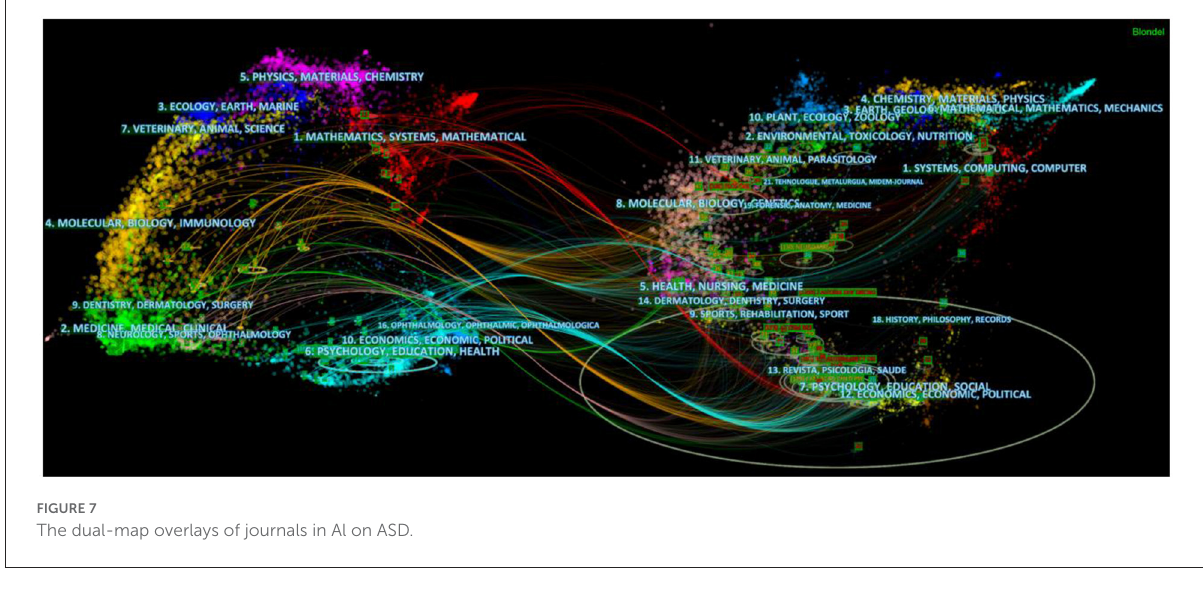
FIGURE7 The dual-map overlays of journals in Al on ASD.